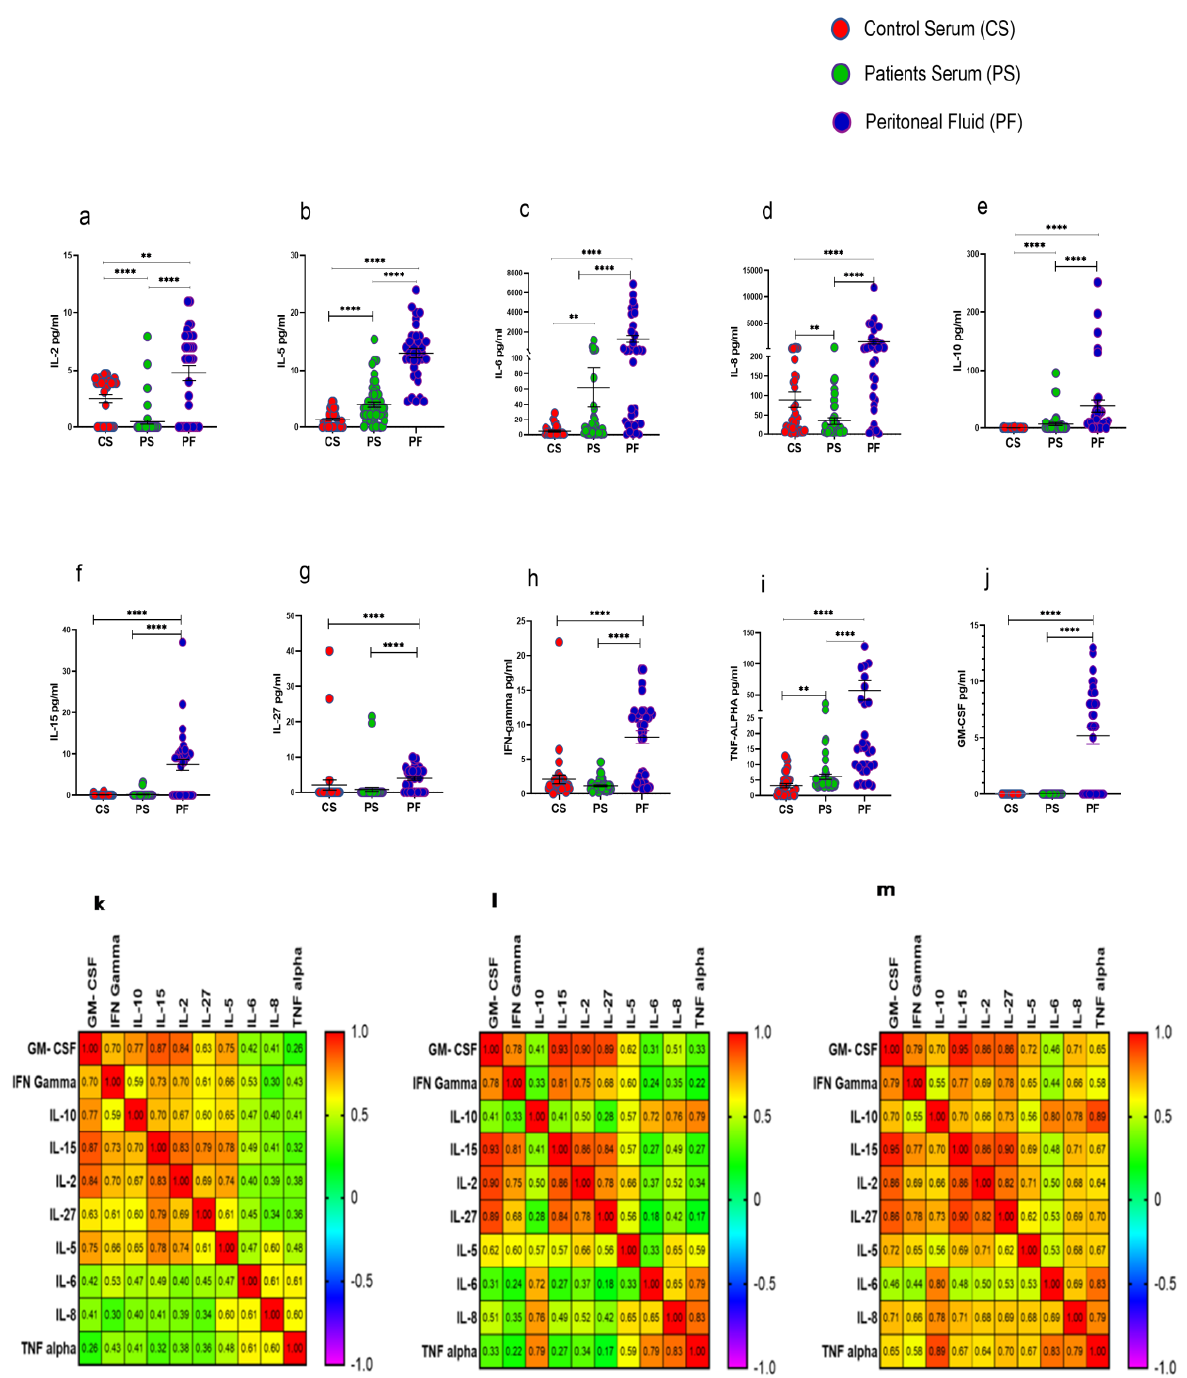
Figure 6. Cytokine profile in Control serum (CS), Patients serum (PS), and peritoneal fluid (PF) ( a – j ); Spearman Correlation matrix of cytokine profile in ( k ) healthy serum, ( l ) patient’s serum, and ( m ) peritoneal fluid. ** p < 0.01; **** p < 0.0001.